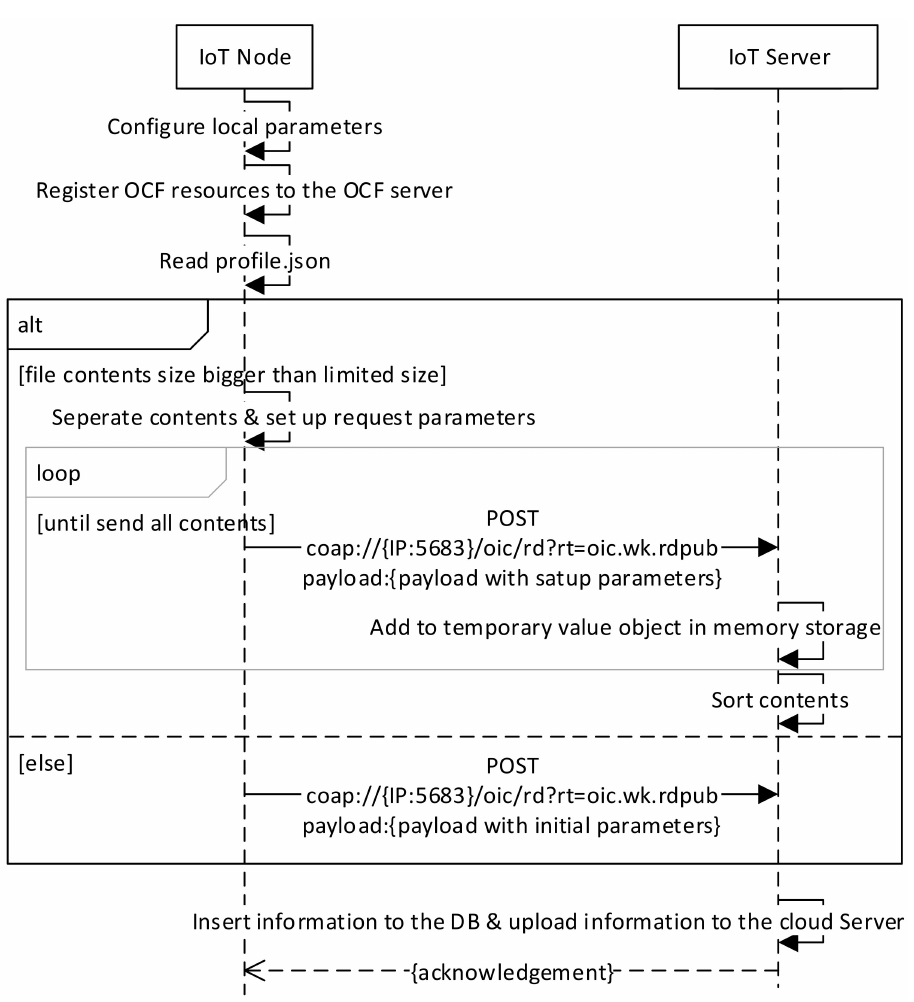
Figure 4. Sequence diagram for the proposed